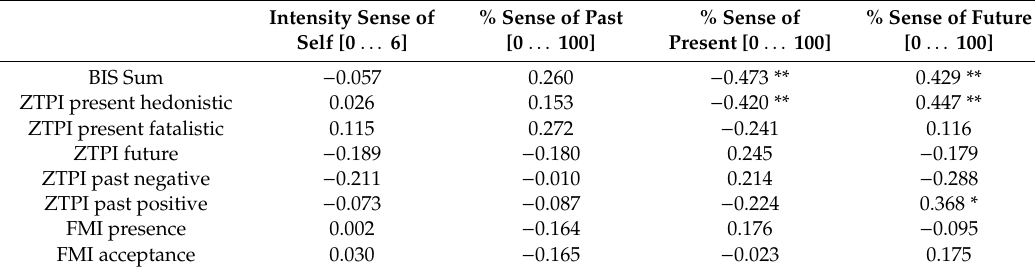
FMI acceptance 0.030 − 0.165 − 0.023 0.175 * p < 0.05, ** significant after